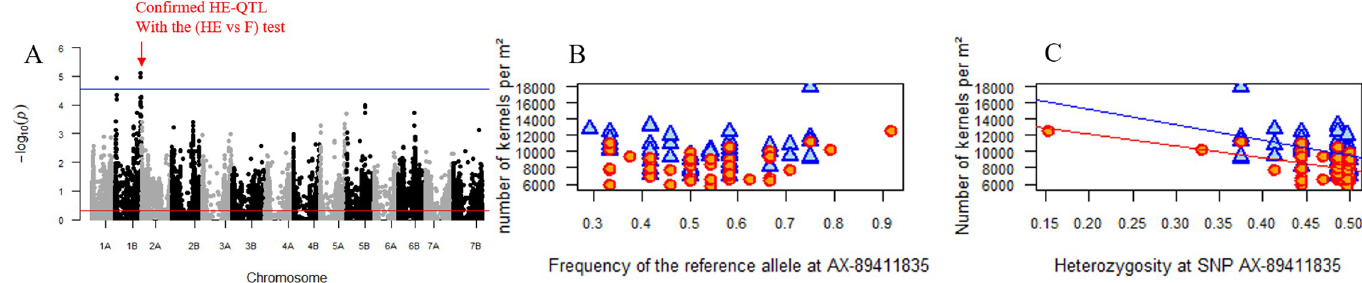
Fig 3. Association between the number of kernels per m 2 (NKM2) and genomic diversity. (A) Manhattan plot reporting p-values (-log10 transformed) for the association tests between NKM2 and diversity index (Nei’s diversity) at 31k eligible SNPs distributed along the durum wheat genome (GWDA). The solid blue line represents the Family-Wise Error Rate (FWER) of 5% computed with the Galwey method. The SNP “AX-89411835” located on the chromosome 1B has passed the He vs. F test (see text). (B) Association between of the 96 allelic frequencies of the SNP “AX-89411835” in the mixtures and their NKM2 values. Red points correspond to control water deficit plots, blue points to rain-fed plots. (C) Relationships between the genetic diversity of the SNP “AX-89411835” and NKM2. Lines are the slopes of regression. The slope for the controlled water deficit treatment has been computed without the outlier point on the x-axis.